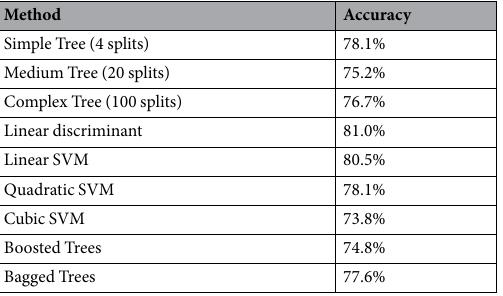
Table 1. Preliminary assessment of linear and non-linear models. Linear support vector machine (SVM) was the selected model.